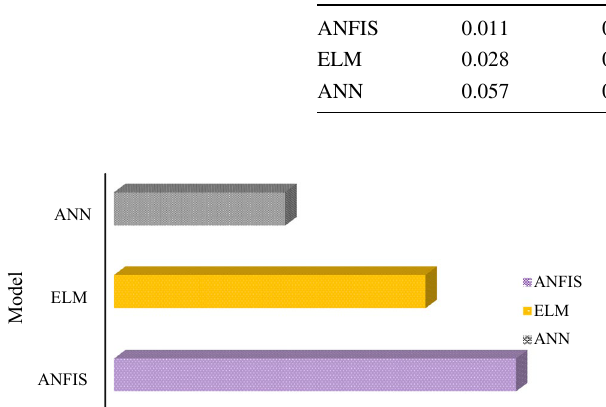
Table 10 Comparison of ANFIS, ELM, and ANN in estimating WP and WPe